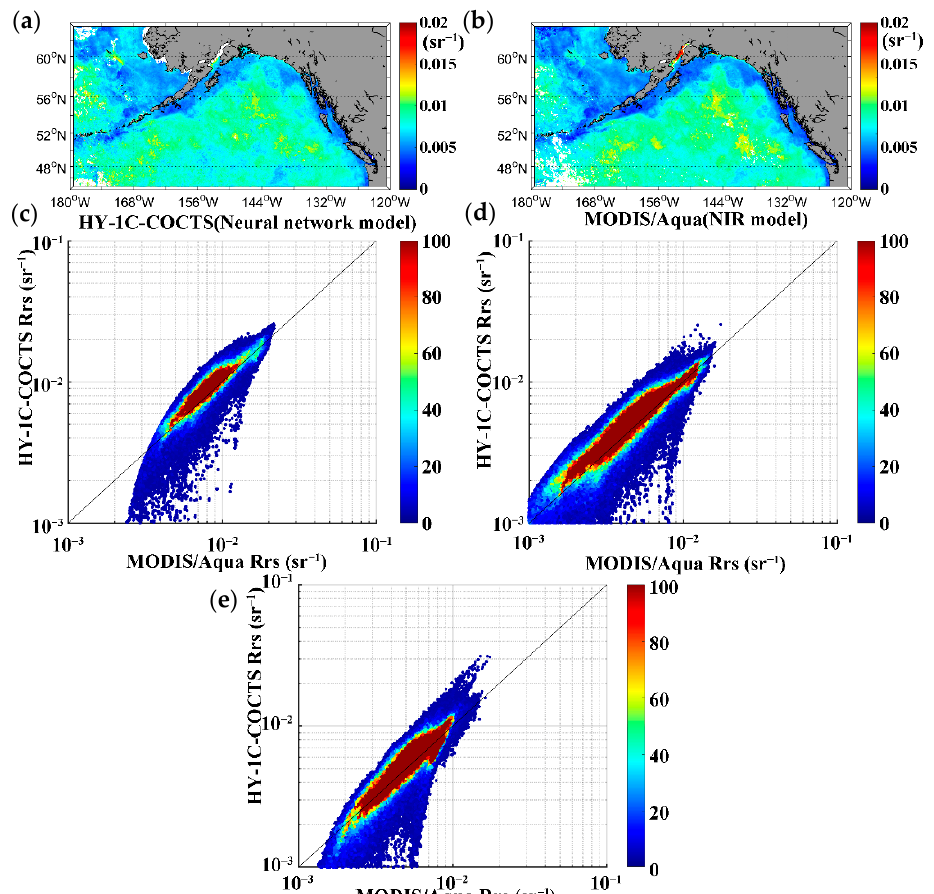
Figure 7 . The monthly average Rrs product of HY-1C-COCTS and MODIS/Aqua in May 2020 calculated using the neural network algorithm and NIR iterative atmospheric correction algorithm. ( a ) The 443 nm Rrs product of HY-1C-COCTS. ( b ) The 443 nm Rrs product of MODIS/Aqua. ( c – e ) Comparison of the results of two algorithms for processing HY-1C-COCTS and MODIS/Aqua data in 412 nm, 443 nm, and 488 nm, respectively. The color bar represents the number of points.